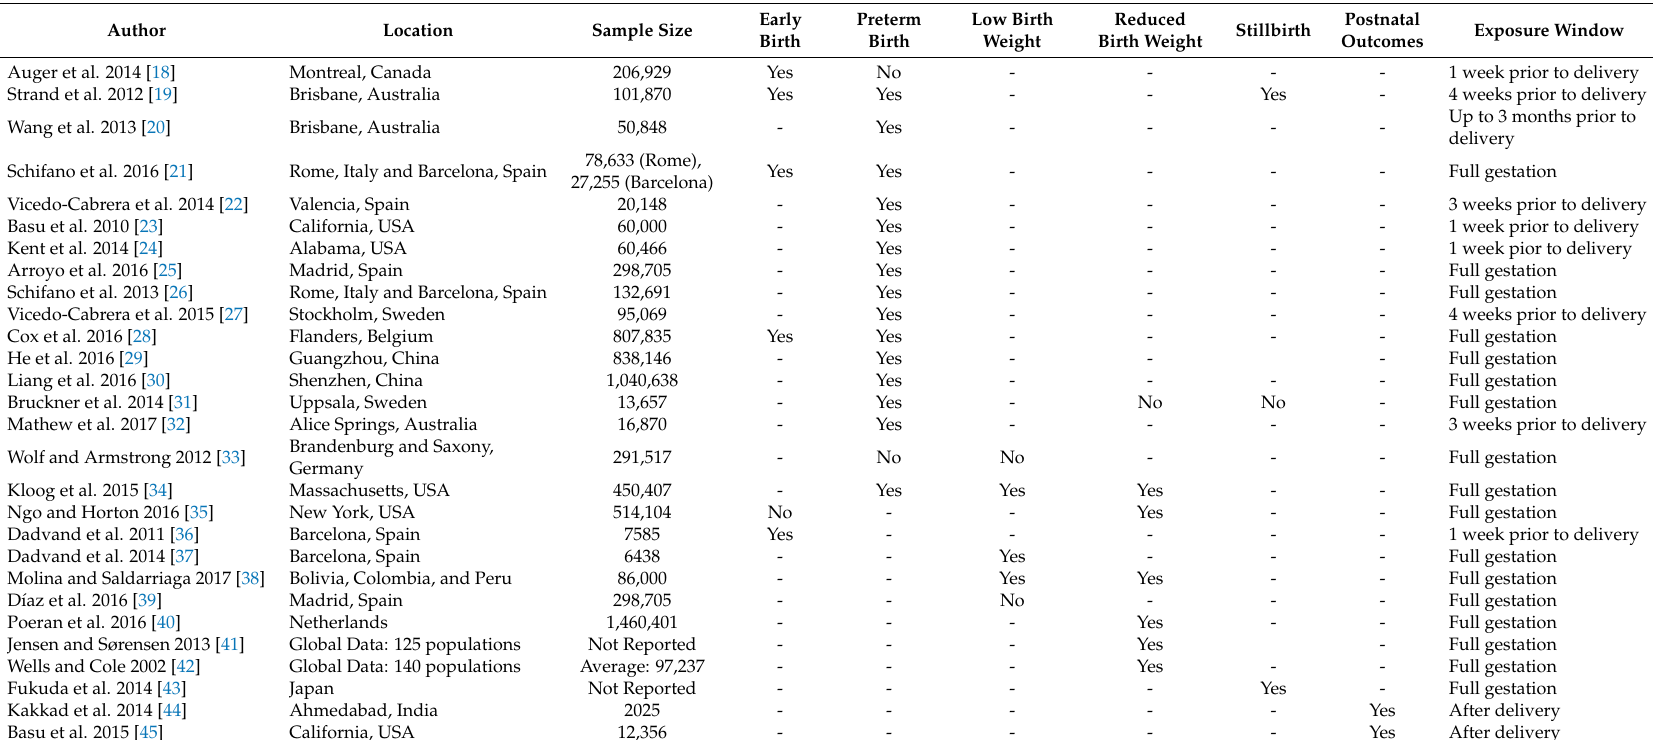
Table 1. Study characteristics, significance within individual study findings, and exposure